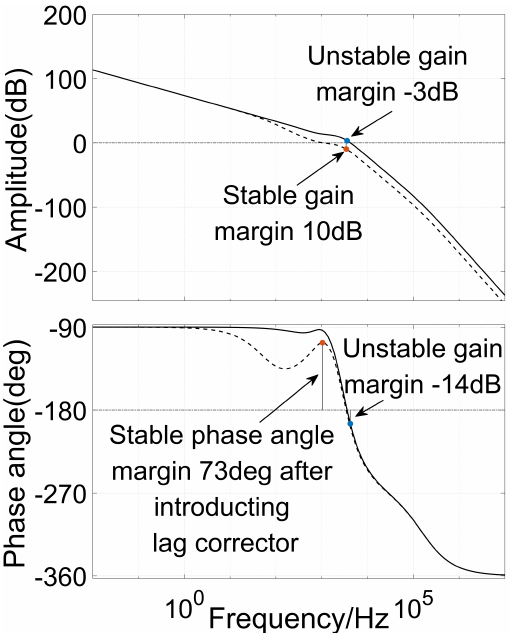
Figure 14. Analysis of lag compensation as admittance controller.